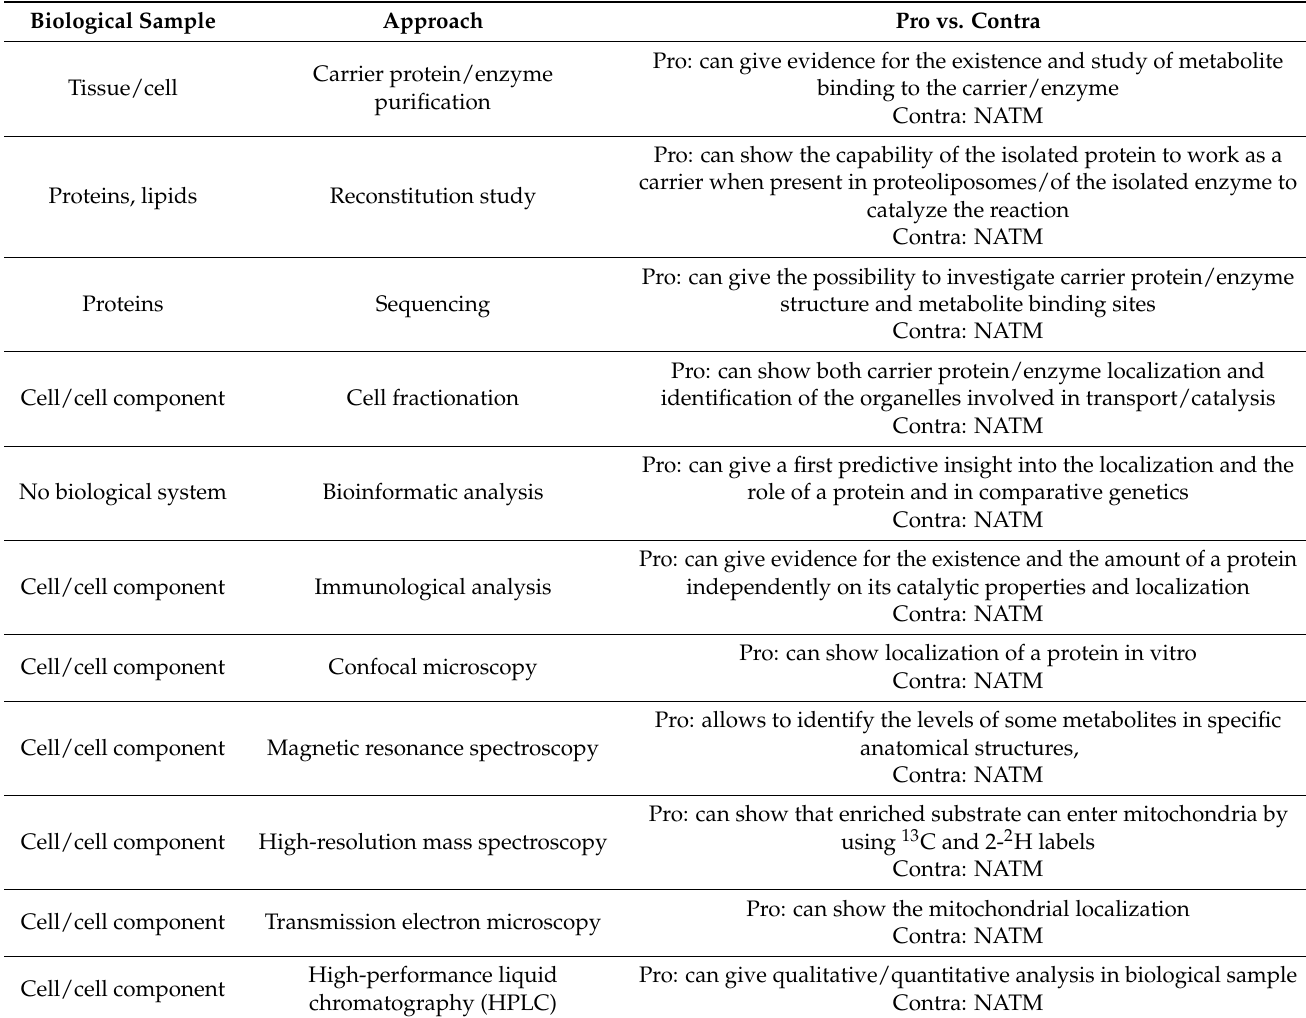
Table 1. Static approach to investigate the role of mitochondrial transport in energy metabolism. Pro vs. Contra. Biological Sample Approach Pro vs. Contra Pro: can give evidence for the existence and study of metabolite Carrier protein/enzyme binding to the carrier/enzyme Tissue/cell purification Contra: NATM